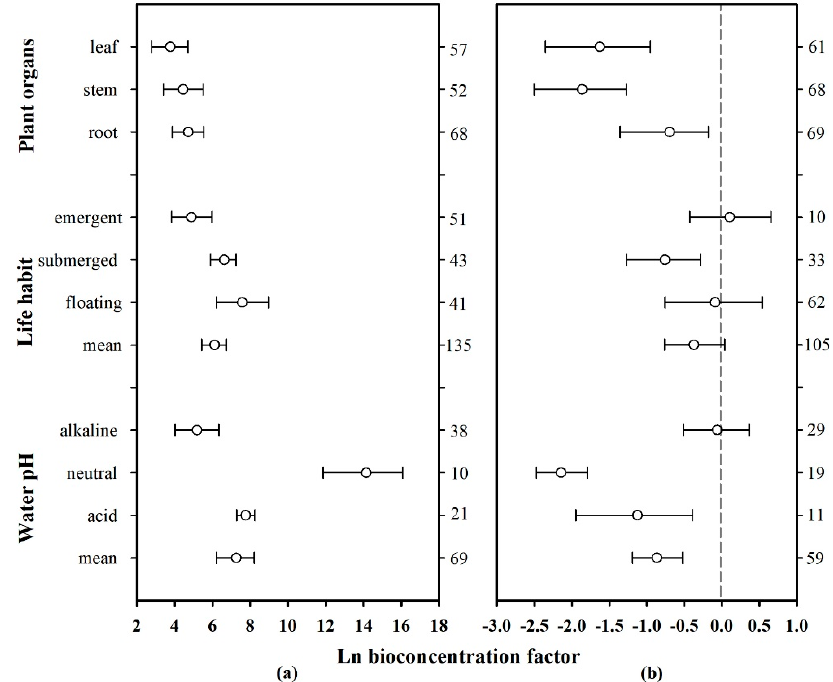
Figure 6. Mean biological concentration factor (BCF) values of Hg in aquatic plants based on pH, life habit, and plant organs. The pH values were classified as follows: acid (<6.5), neutral (6.5–7.5), and alkaline (>7.5). The error bars represent 95% bootstrapped CIs, and the numerals on the right y-axis represent the number of observations in each category. “Mean” indicates the overall effect considering all the observed plant families. ( a ) Hg absorption by plants from water. ( b ) Hg absorption by plants from sediments.